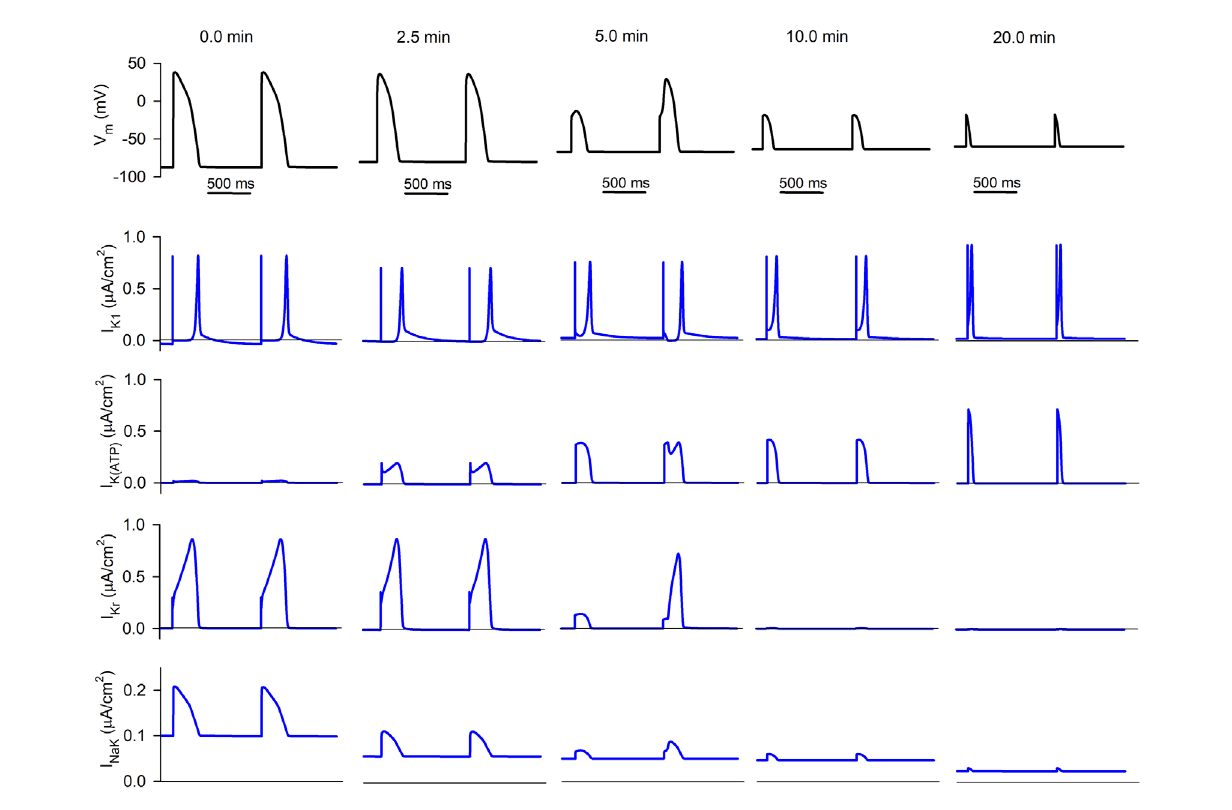
FIGURE 4 Simulated APs and selected ionic currents in an acutely ischemic isolated ventricular cardiomyocyte. Top row (black traces): consecutive APs 0.0, 2.5, 5.0, 10.0, and 20.0 min after the onset of progressive ischemia. Lower rows (blue traces): inward rectifier potassium current ( I K 1 ) , ATP-sensitive potassium current ( I K ( ATP ) ) , rapid delayed rectifier potassium current ( I Kr ) , and sodium/potassium pump ( I NaK ) ,